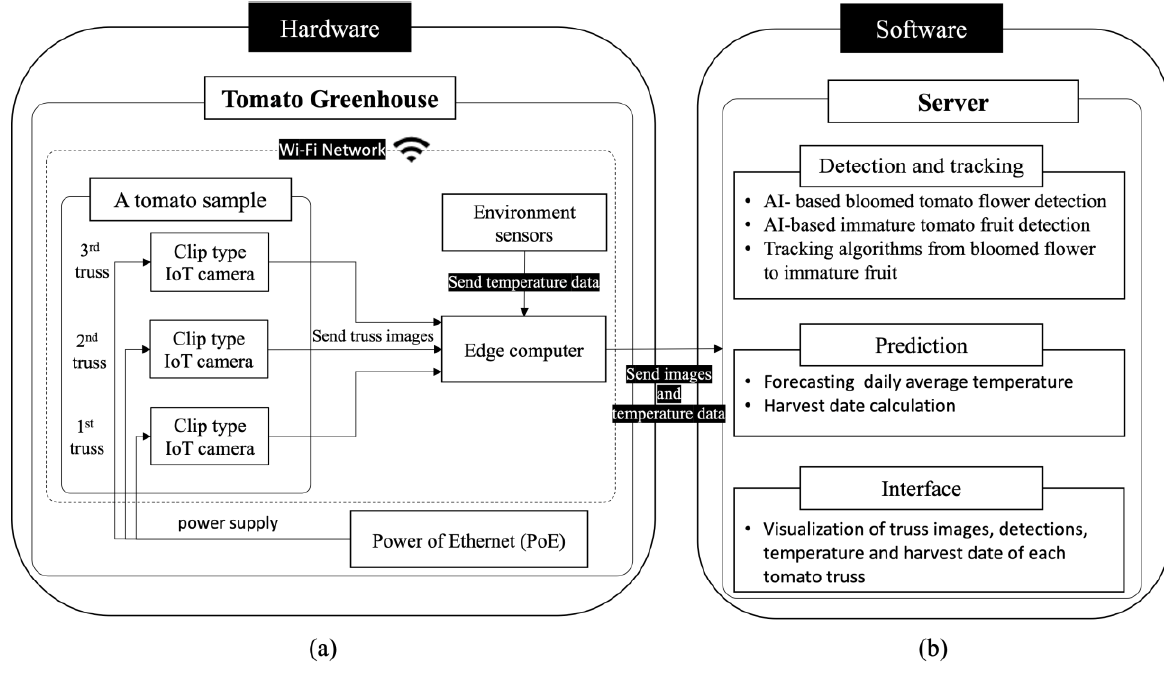
Figure 2. Configuration of system. ( a ) hardware configuration; ( b ) software configuration.